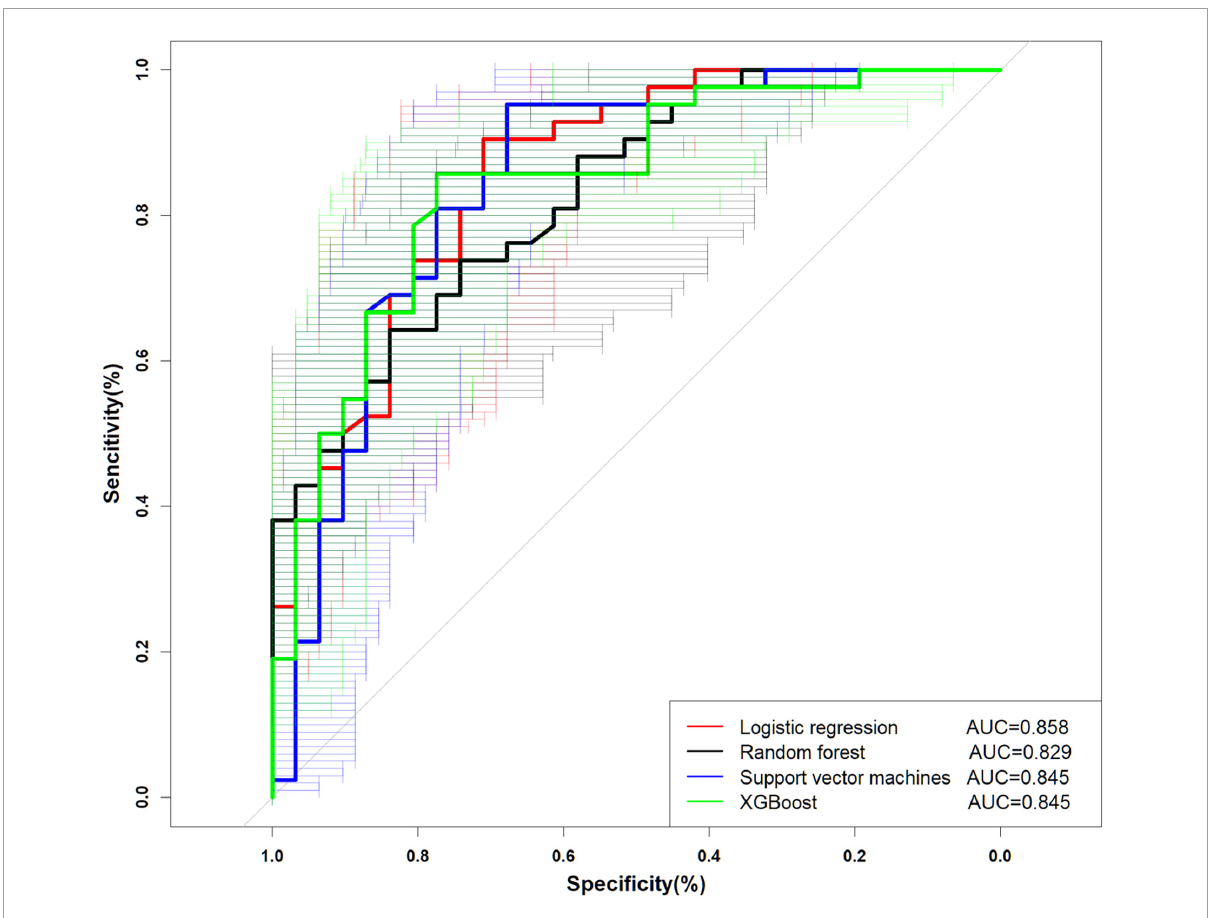
FIGURE2 Performance of the diagnostic models.